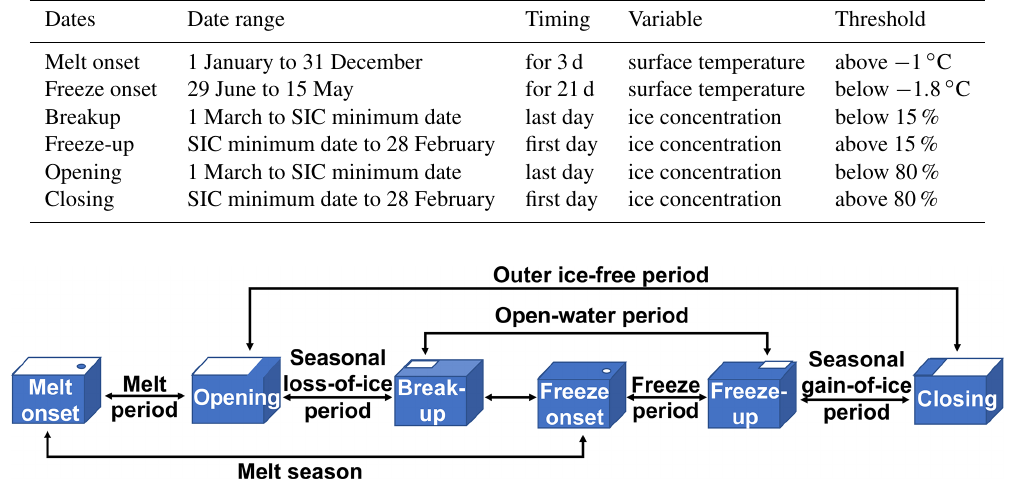
Figure 1. Conceptual diagram of seasonal sea ice transitions, beginning with spring melt onset and ending with fall ice closing. Transition dates (Table 1) as well as interseasonal and intraseasonal transition periods (Table 2) are labeled.